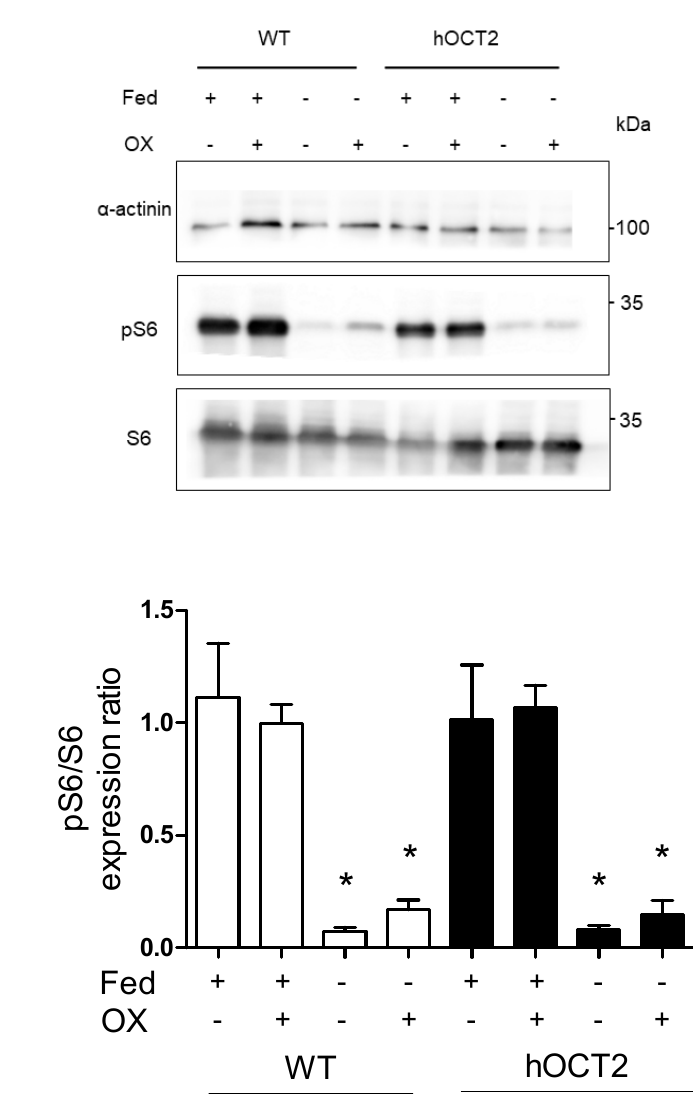
Figure 5. This figure shows the results of experiments aimed to measure the effect of OX incubation and/or starvation on the mTORC signaling pathway in HEK293-WT (WT) and -hOCT2 (hOCT2) cells. Activation of mTORC signaling pathway was measured by Western blot analysis of pS6/S6 expression ratio in WT (open bars) and hOCT2 (closed bars) cells under fed and starvation conditions and OX treatment. α -actinin served as a loading control. Panel ( A ) shows a representative Western blot analysis, panel ( B ) shows the quantification of the results (mean ± SEM) from 3 independent experiments. The mTORC signaling pathway is downregulated by starvation in both WT and hOCT2 cells. * indicate a statistically significant difference between fed and starvation conditions ( p < 0.05, Anova with Tukey post hoc test). Treatment with 100 µ M OX for 6 h under fed or starvation condition did not significantly change the activity of the mTORC pathway compared with experiments performed without OX